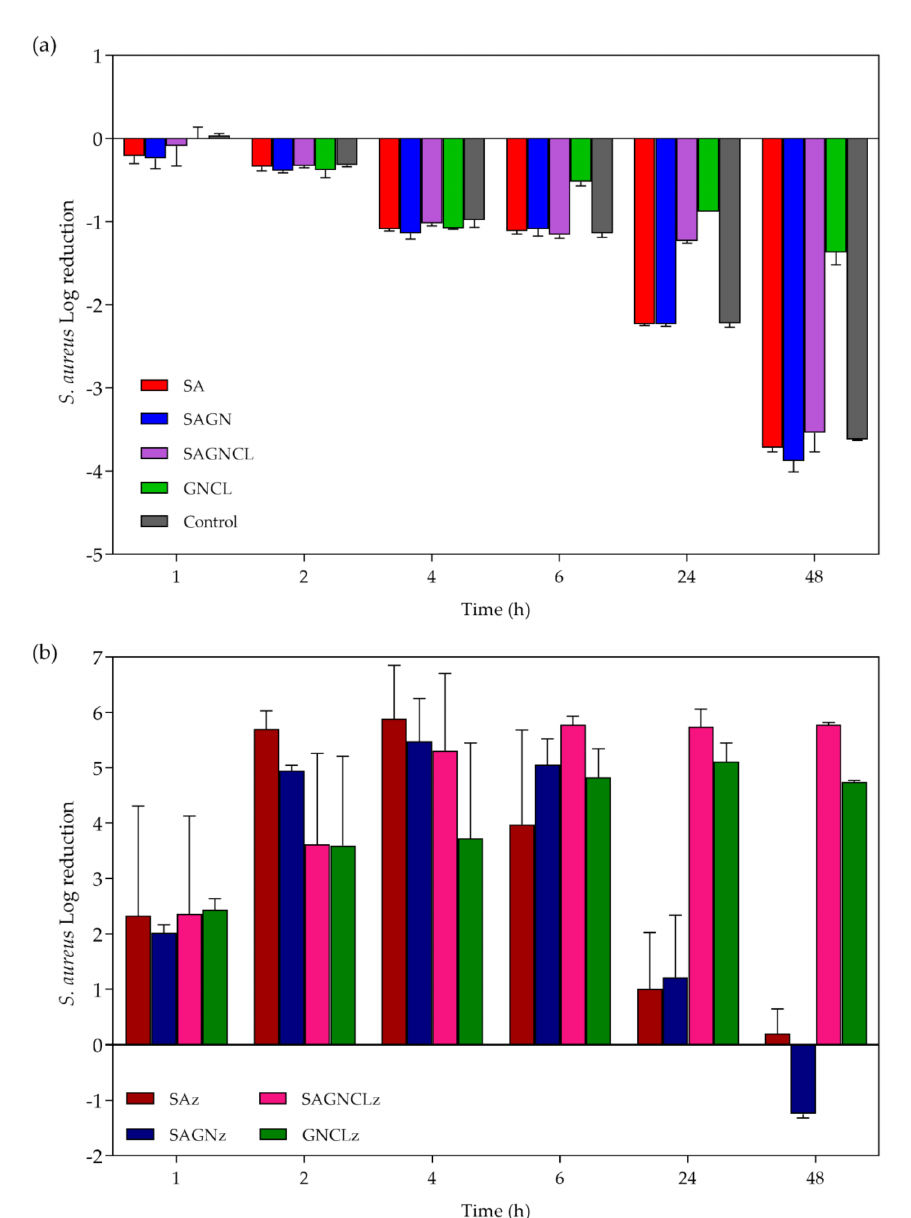
Figure 8. S. aureus log reduction in contact with ( a ) unloaded and ( b ) Nisin Z-loaded fibers after 1, 2, 4, 6, 24 and 48 h of culture. Data derived from three repetitions (mean ±